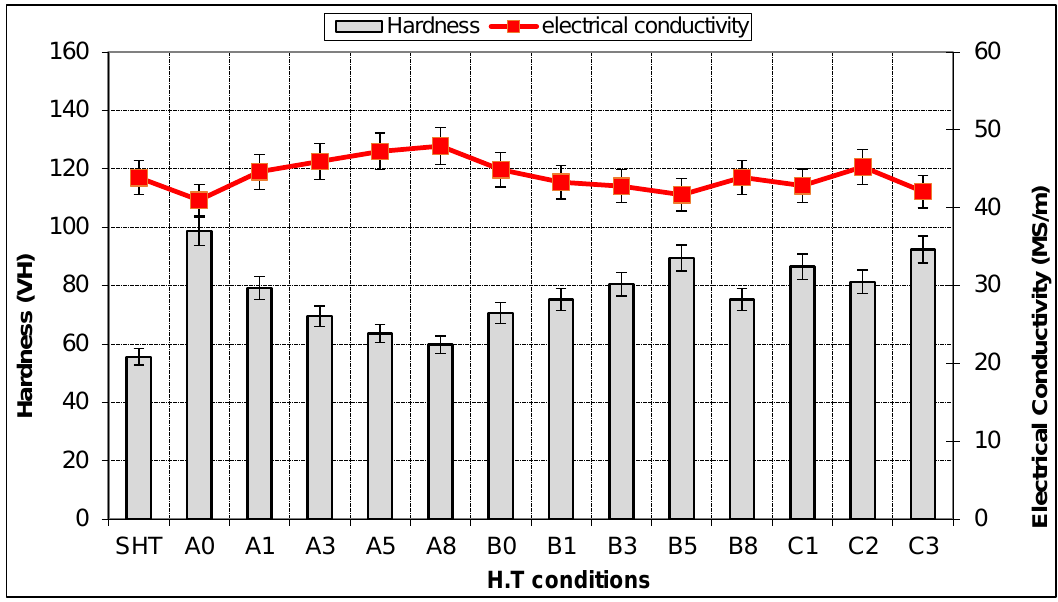
Figure 2. Hardness and electrical conductivity of direct hot air quenching-aging of A357-SSM heat treated using multiple thermal aging treatments.